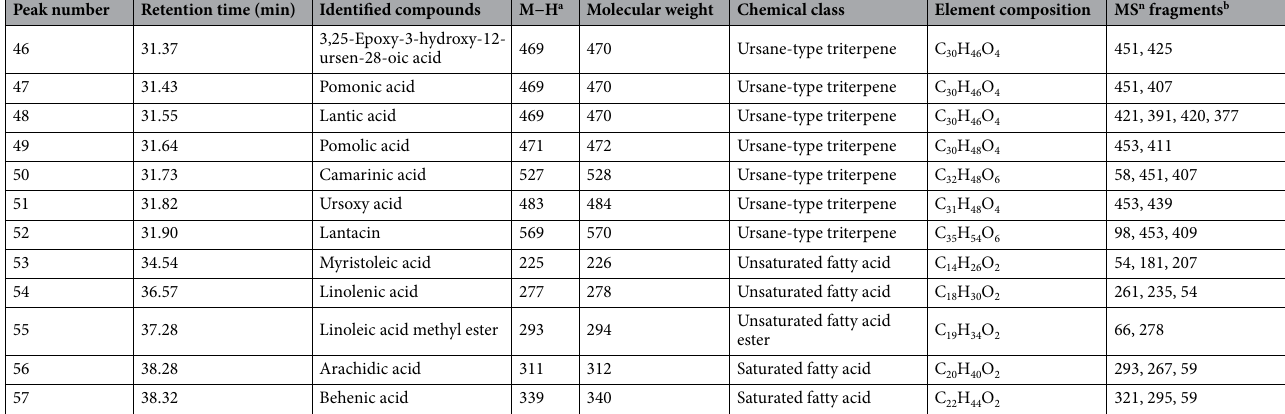
Table 1. Metabolites identified in the extract of L. camara using UPLC-MS/MS in negative ionization mode. a M−H is the quasi-molecular ion that results from ionization of metabolites using Electrospray Ionization technique (ESI). b MSn fragments are the fragments obtained from MS2 fragmentation of ionized metabolites in collision cell of the triple quadrapole mass